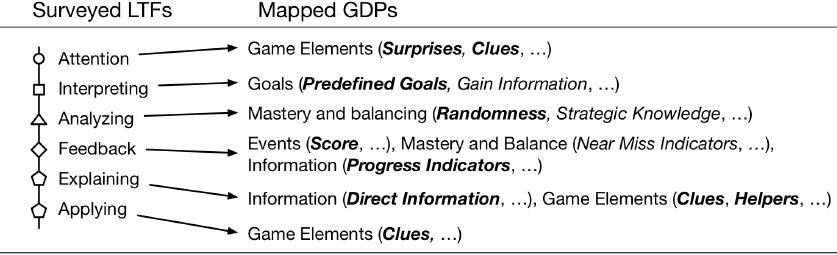
Figure 2. Sub-set of LTFs and corresponding GDPs. Taken from